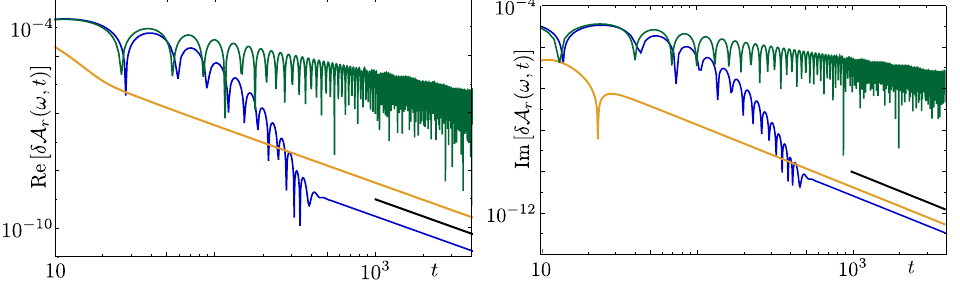
Figure 2: Plot of real (left panel) and imaginary (right panel) part of δ A ( ω , t ) = A < ( ω , t ) − ¯ A ( ω ) (units v − 1 ) as a function of time for different tempera- r r r f tures: T = 10 − 1 (orange), T = 10 − 2 (blue), T = 0 (green). Black lines show a power-law decay ∝ t 2 (left panel) and ∝ t − 3 (right panel). Here ω = 0.1 ω units ω − 1 and temperature units ω . We have included the zero temperature case (green i f curve) to underline the difference with the finite temperature